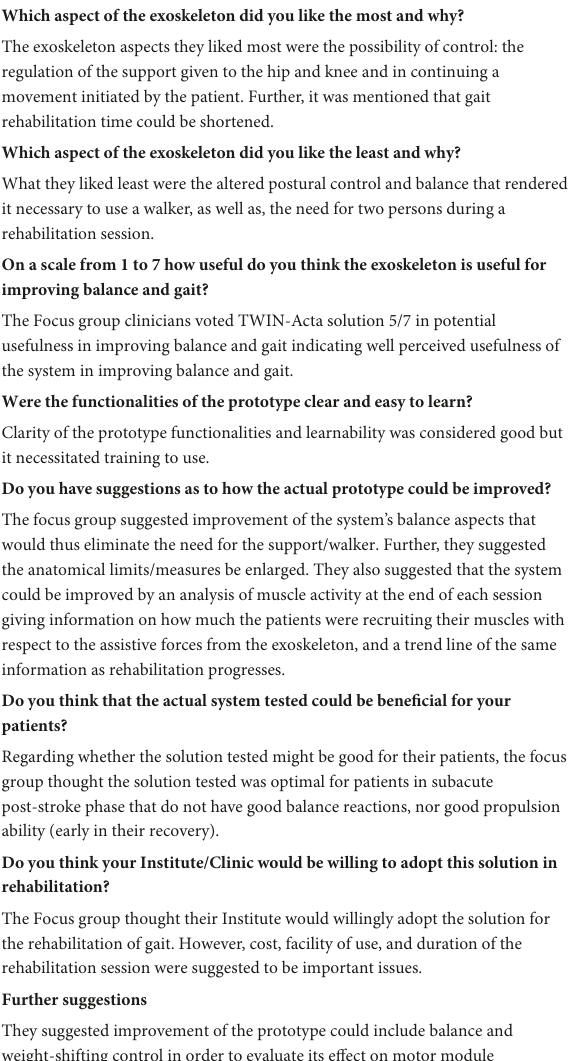
Which aspect of the exoskeleton did you like the most and